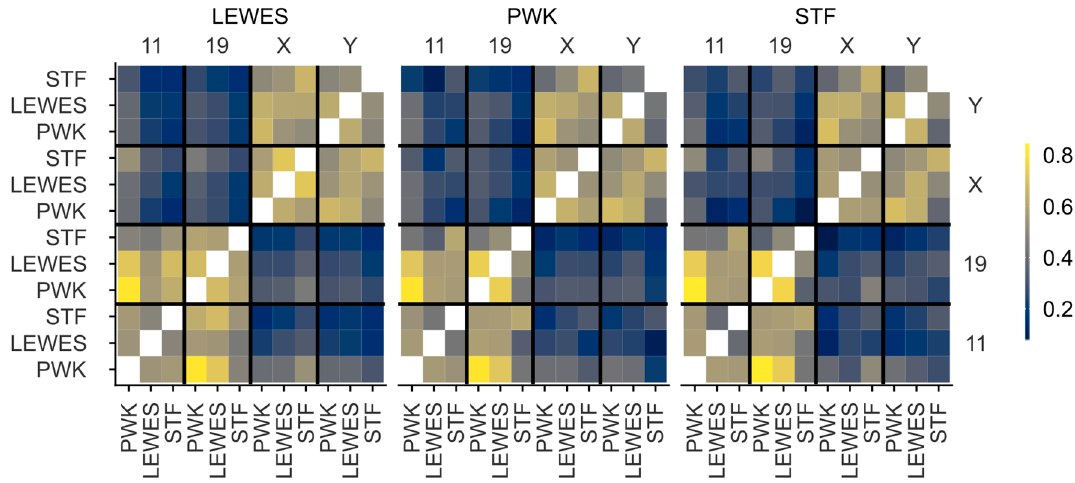
Figure 7. Similarity of signal distributions in composite warped images measured by MS-SSIM*, on a scale of 0–1, where 0 indicates no similarity, and 1 indicates identical images. Images were warped in turn onto the consensus shapes of LEWES, PWK and STF. There is high correlation between the MS-SSIM* scores obtained when images are warped onto different target shapes (see Figure S2). Both within strains and between strains, there is a clear similarity between the distributions of chrX and chrY, and chr11 and chr19, but little similarity between the reciprocal combinations.